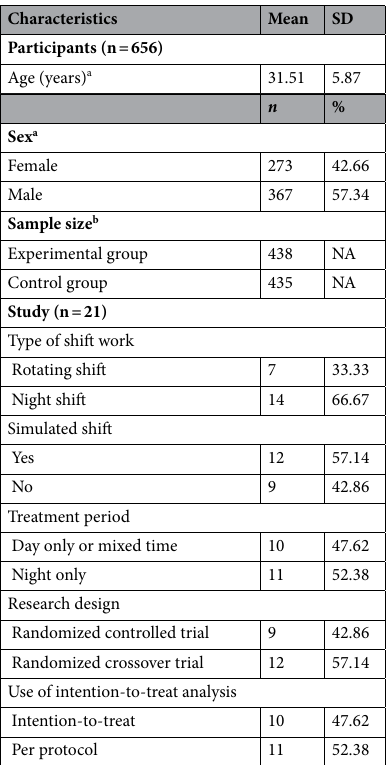
Table 1. Study characteristics. SD standard deviation, NA not applicable. a Missing value in (number of study): mean age (3), SD age (4), sex (1). b Sample size: participants were included in both intervention and control groups in randomized crossover